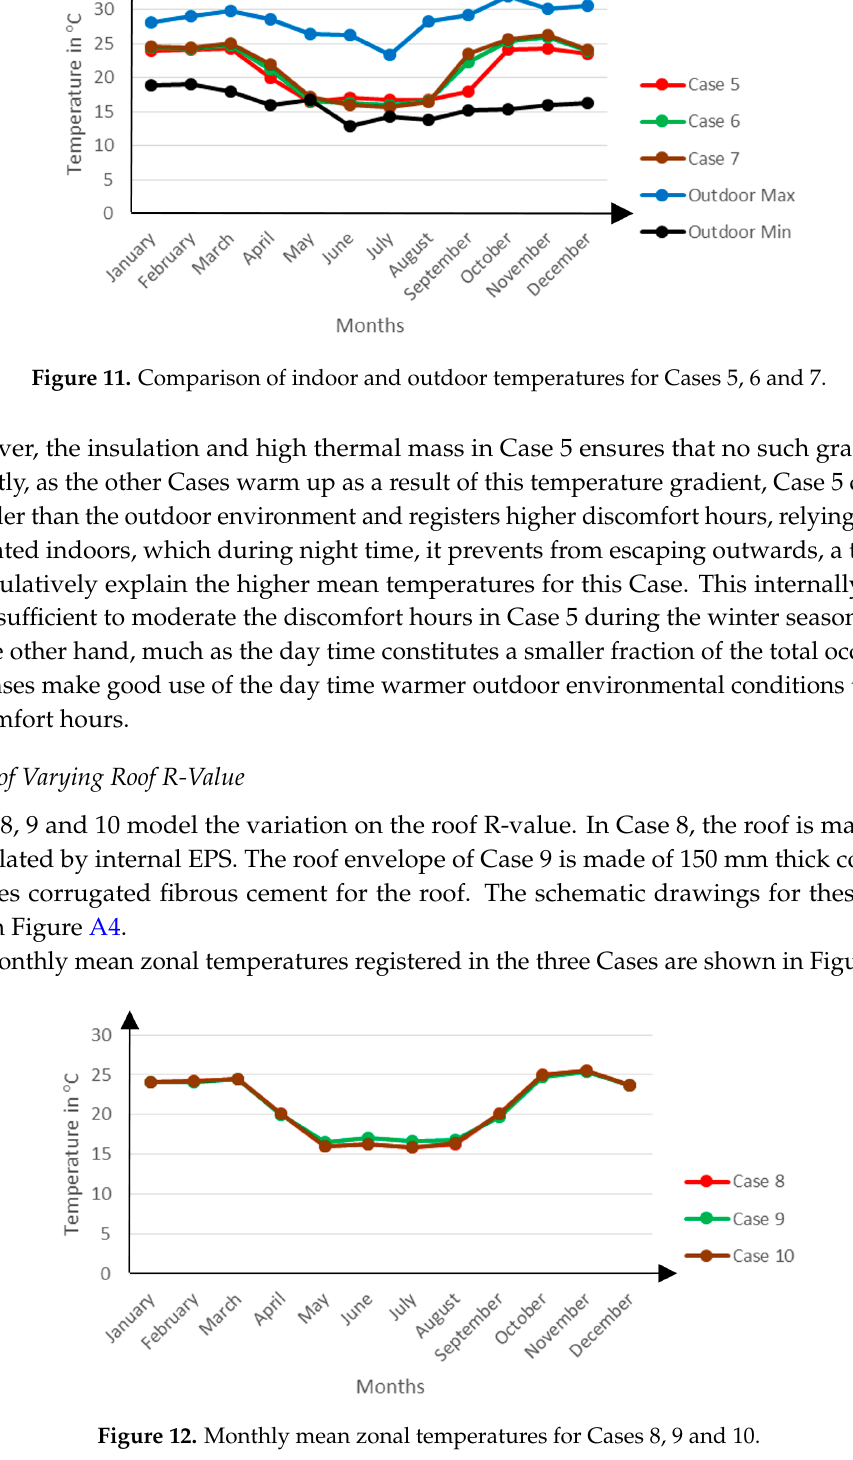
Figure 10. Discomfort hours for Cases 5, 6 and 7.